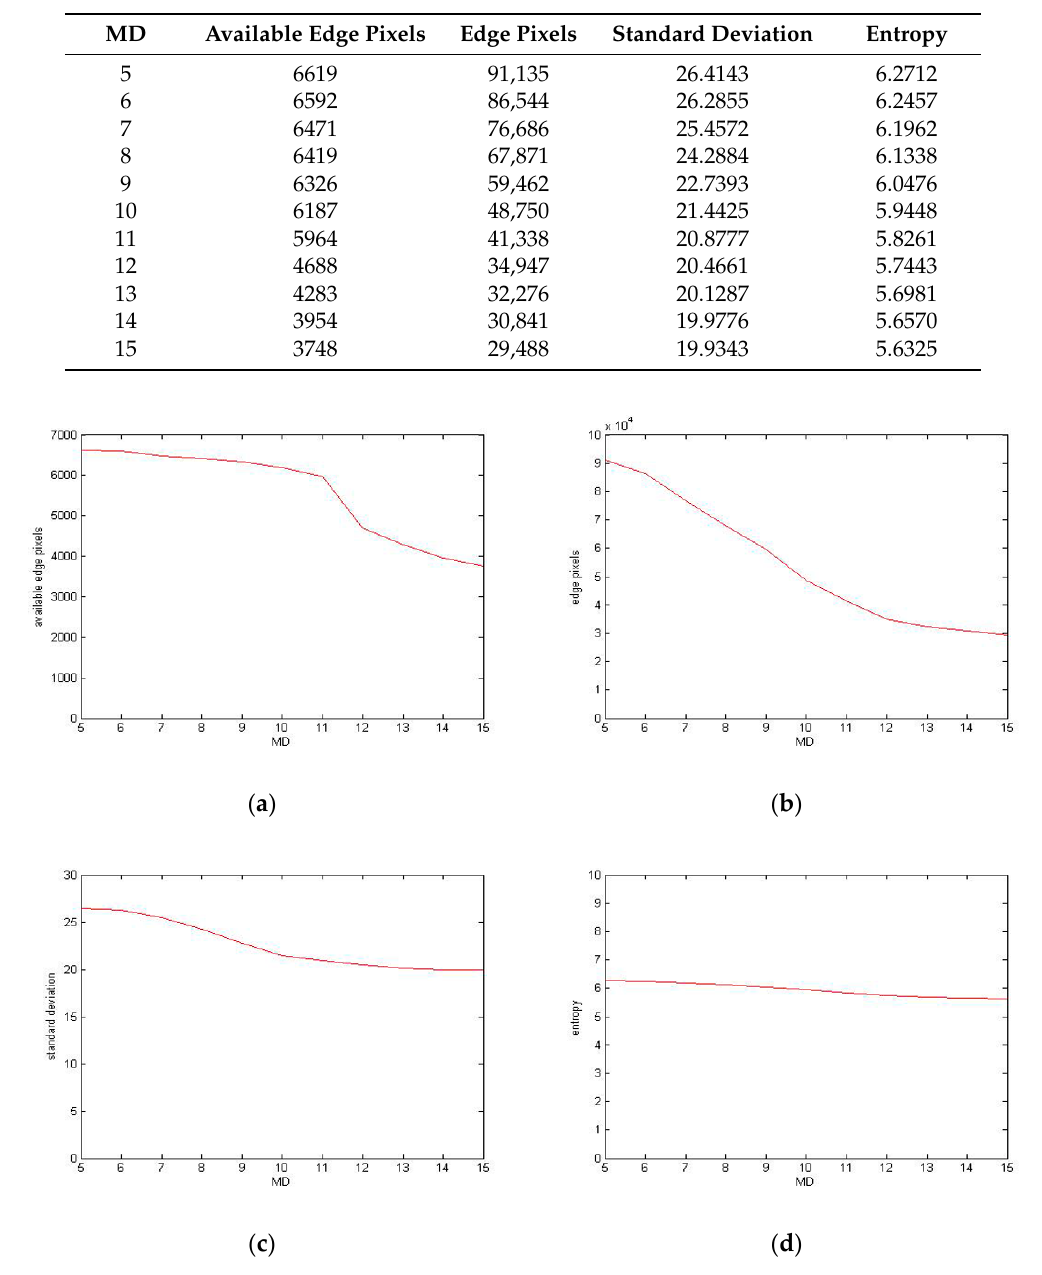
( b ) Figure 13. ( a ) The values of Acc corresponding to the values of different parameter C. ( b ) The values of Acc corresponding to the values of different parameter S.